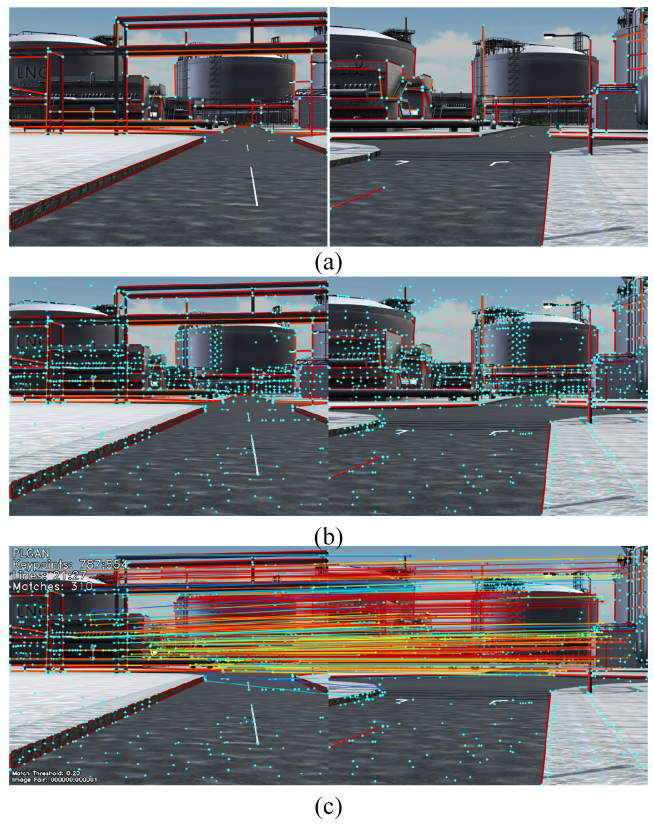
Figure 12. The effect of point–line feature tracking. ( a ) The line-segment extraction results. ( b ) The point and line-segment extraction results. ( c ) The point and line matching results. We visualized the matching results with RGB color.